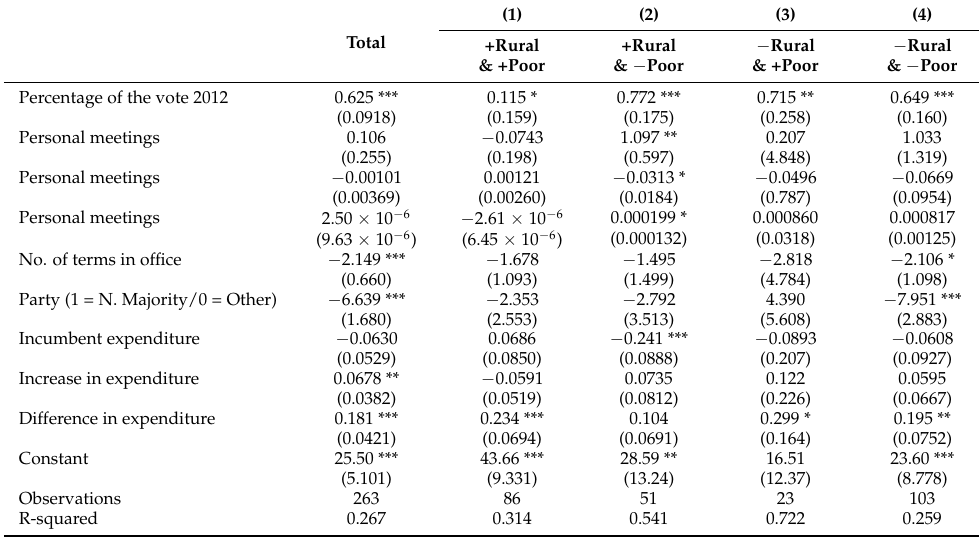
Table 2. Predictors of mayors’ percentage of the vote